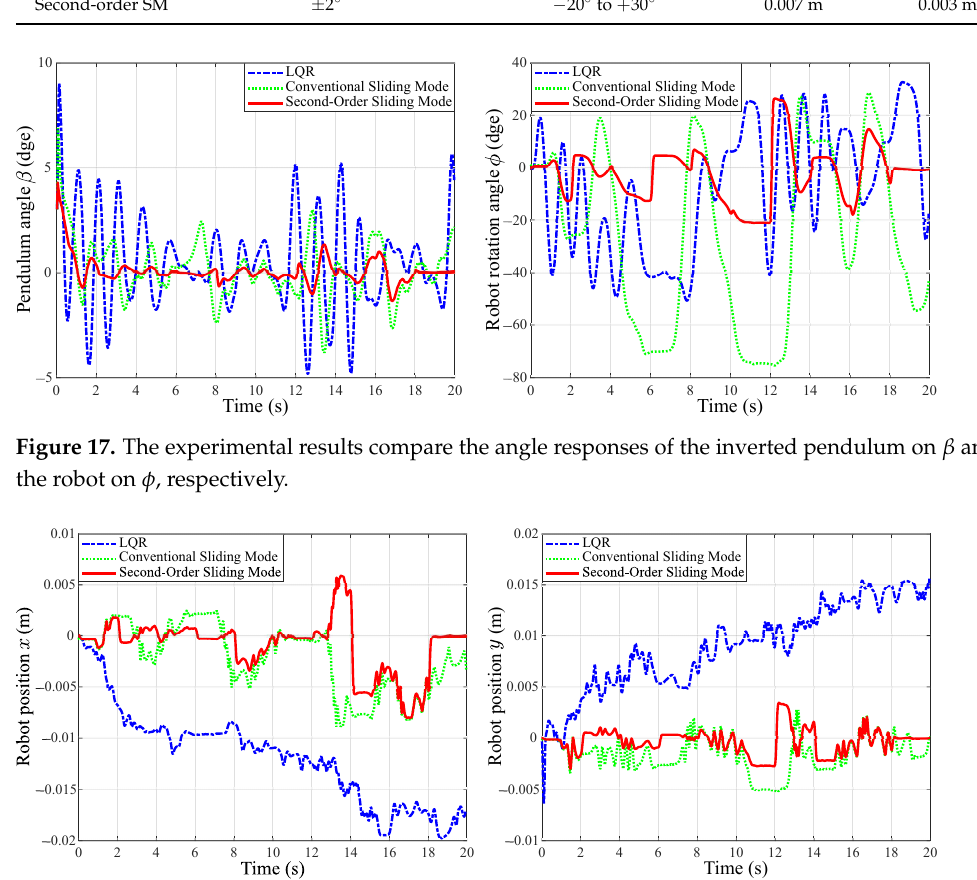
Figure 18. The experimental results of the rotary inverted pendulum compare the robot’s position responses on the X -axis and Y -axis,